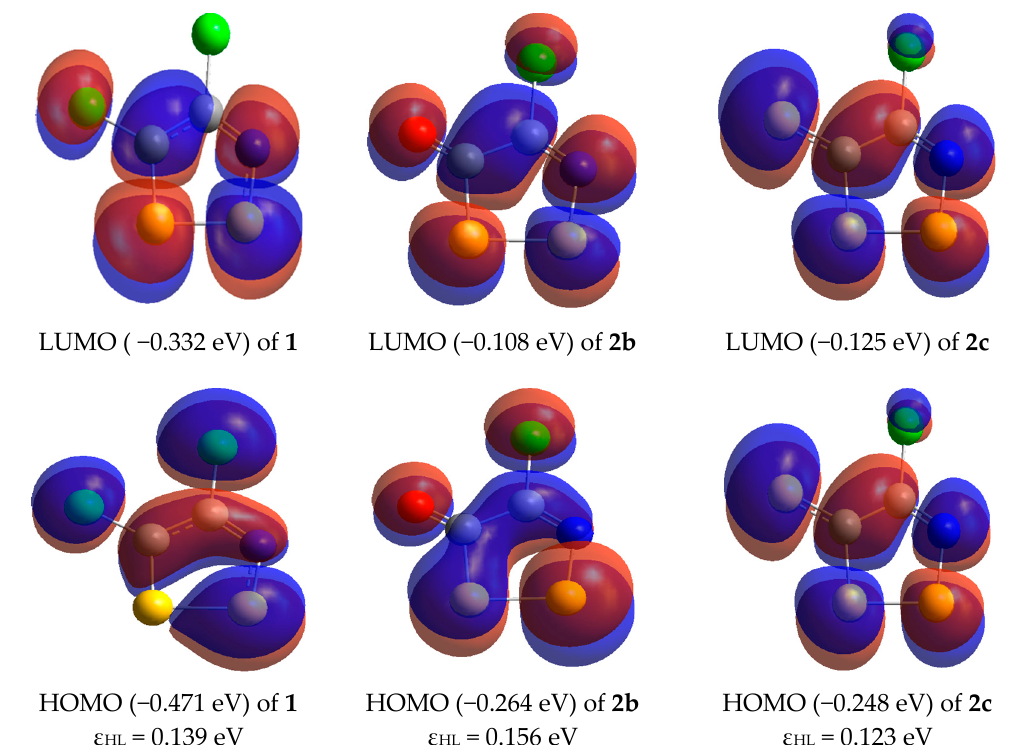
Figure 4. HOMO and LUMO orbitals calculated at the B3LYP/def2-TZVPD level of theory along with their energies (eV) and the ε HL : HOMO-LUMO gap (eV) for Appel’s salt 1 , dithiazolone 2b and dithiazolethione 2c .